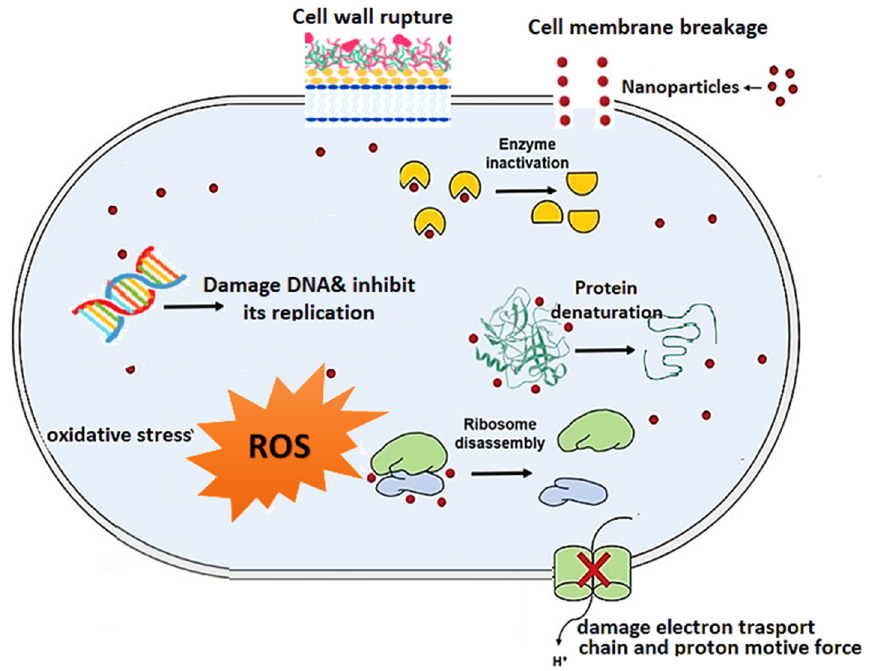
Figure 5. Mechanism of action of nanoparticles in bacterial